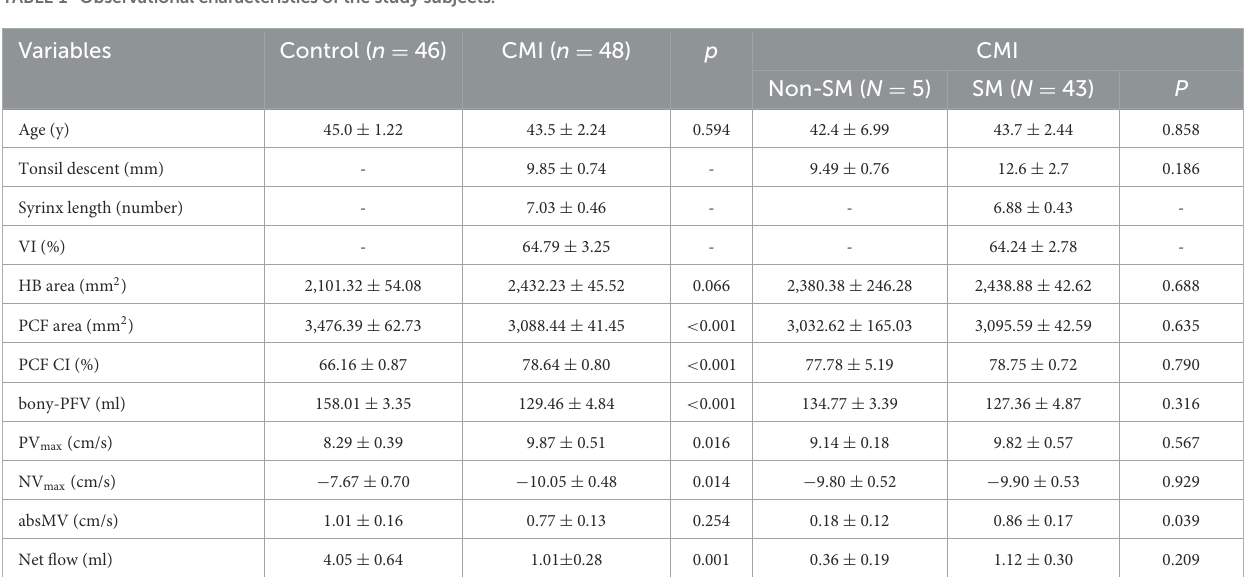
TABLE 1 Observational characteristics of the study